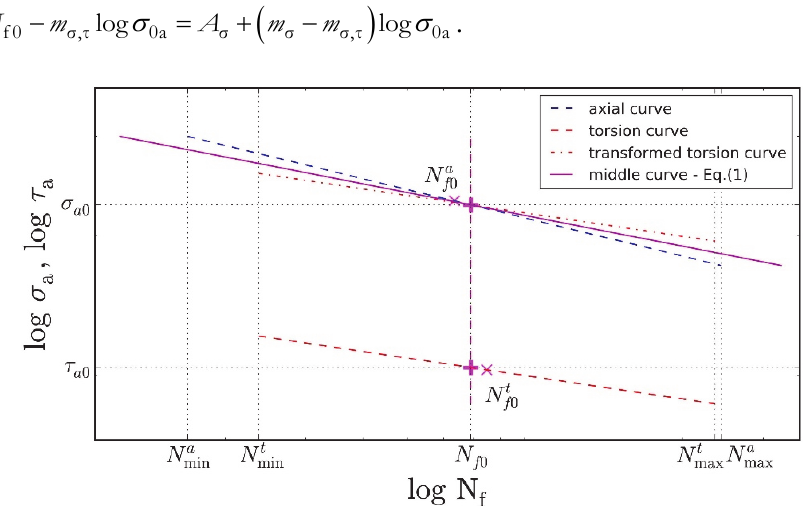
Figure 1: Definition of N f0 , σ a0 , and τ a0 using data of S355J2G3 alloy steel reported by Karolczuk et al.